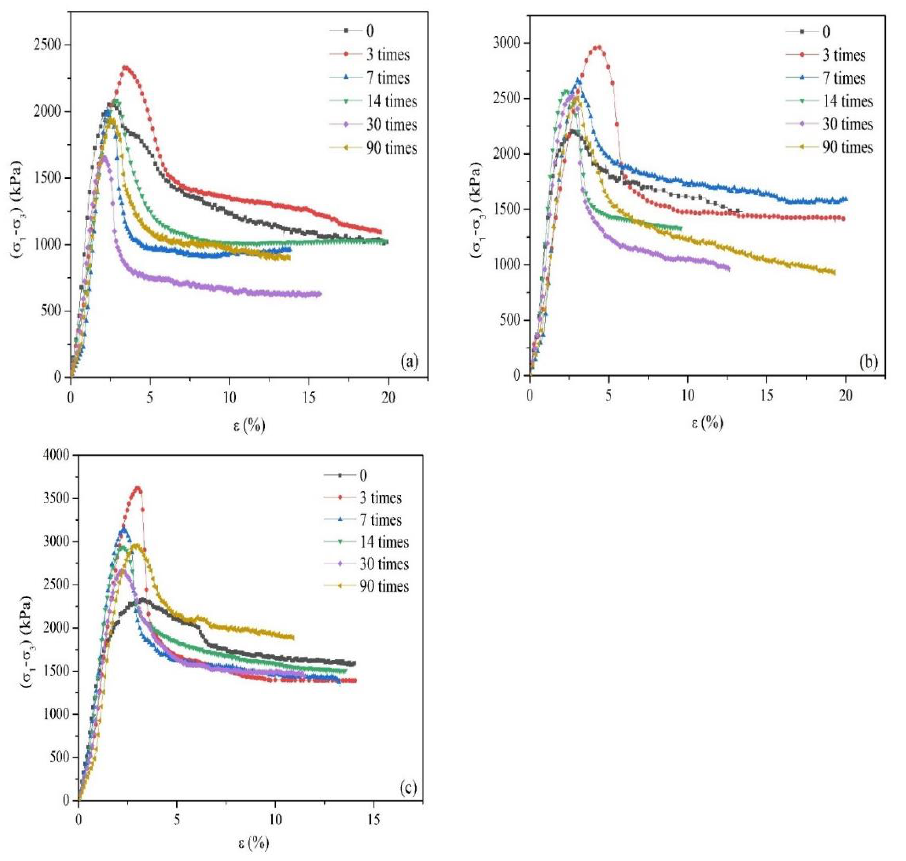
Figure 5. Stress–stain relationships of stabilized/solidified lead-zinc-cadmium composite heavy metal-contaminated soil under three confining stresses: ( a ) 100, ( b ) 200, and ( c ) 300 kPa.